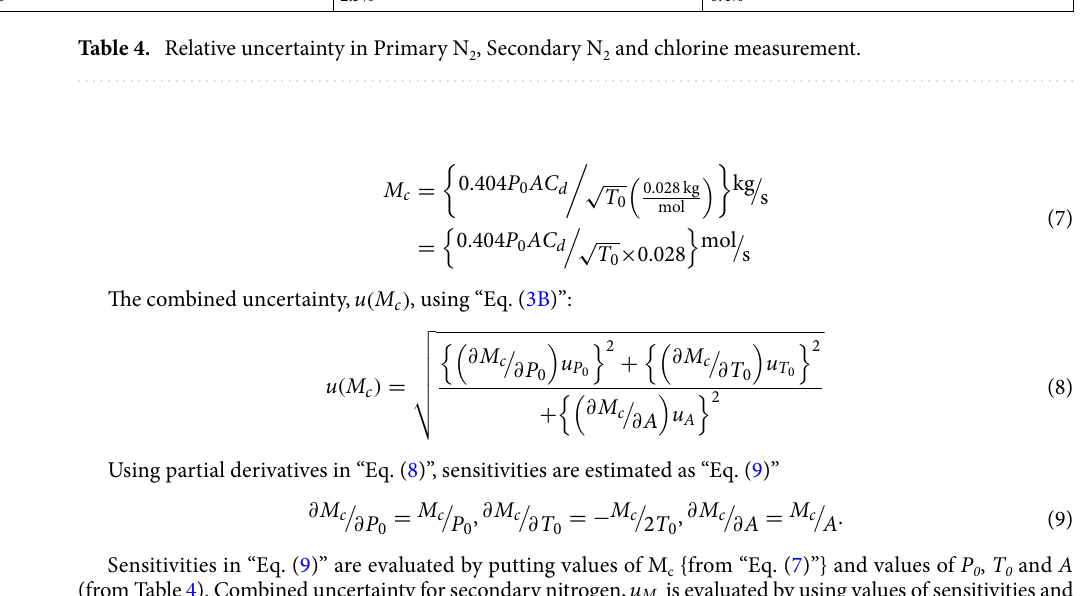
Sensitivities in “Eq. (9)” are evaluated by putting values of M c {from “Eq. (7)”} and values of P 0 , T 0 and A (from Table 4). Combined uncertainty for secondary nitrogen, u M is evaluated by using values of sensitivities and c uncertainties of P 0 { u ( P 0 )}, T 0 { u ( T 0 )}, A { u ( A )} (all from Table 4) and found to be, 1.1 × 10 –2 mol/s. EPR provides controlled flow of secondary nitrogen by special software program developed using LabVIEW in developed ( M c ) DAAS. Relative uncertainty in secondary nitrogen flow rate measurement is estimated as: u M c and listed in Table 4. (cid:31) One of the most critical parameter influencing system performance is the uncertainty in measurement of the lasing species (iodine) . Iodine is available in solid crystal form at room temperature (25 °C). Hence it is required to be heated to ~ 80 °C (353 K) in order to obtain uniform iodine vapors in iodine evaporator system for achieving proper mixing of singlet oxygen and iodine vapors occurs in the supersonic nozzle. The stabilization of vapors at indicated temperature is obtained by using pulse width modulation (PWM) based temperature stabilization (Proportional derivative controller, PID, Model no. MC-2438-201-000, Make: Max. Thermo, Taiwan). The pre- cipitation of iodine during transport before reaching COIL system is prevented by employing heated secondary nitrogen passed through the iodine evaporation system to serve as the carrier. An optical absorption based process is used for iodine concentration measurement. Iodine molar flow rate is expressed using the Beer Lambert law and the perfect gas law equation as “Eq. (10)”,